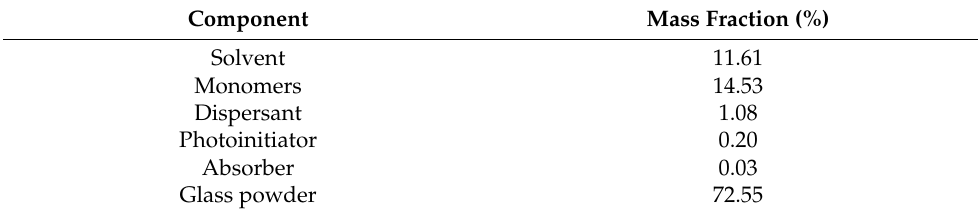
Table 3. Composition of the photo-reactive suspensions.